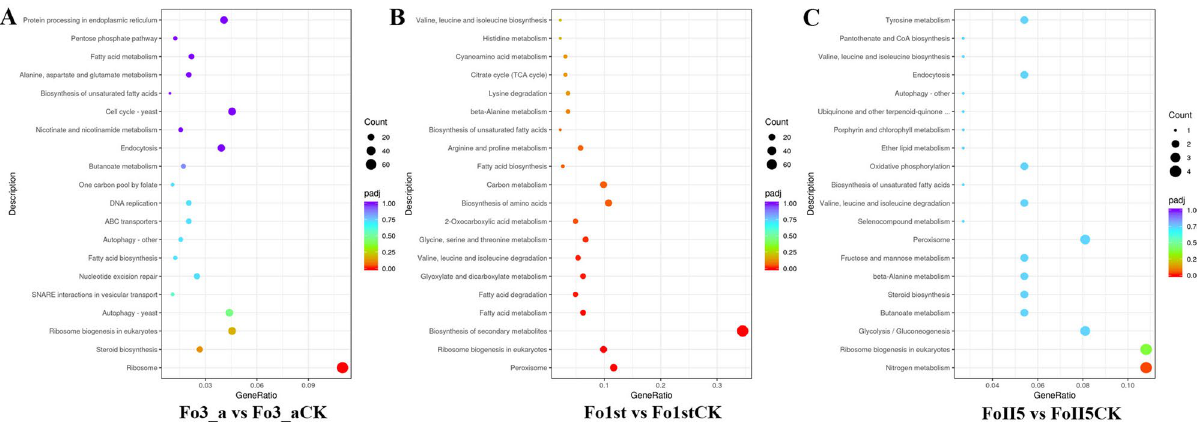
Figure 4. KEGG enrichment analysis of DEGs in all comparison groups. The top 20 most enriched KEGG pathways were shown in a scatter diagram in the comparison groups ( A ) Fo3_a vs Fo3_aCK and ( B ) Fo1st vs Fo1stCK ( C ) FoII5 vs FoII5CK. The abscissa represents the ratio of the number of differential genes annotated on KEGG pathways to the total number of differential genes and the ordinate represents KEGG pathways. The size of small dots represents the number of genes annotated to KEGG pathways, the color from red to purple represents the significance of enrichment, and p adj < 0.05 is used as the threshold of significance enrichment for KEGG enrichment